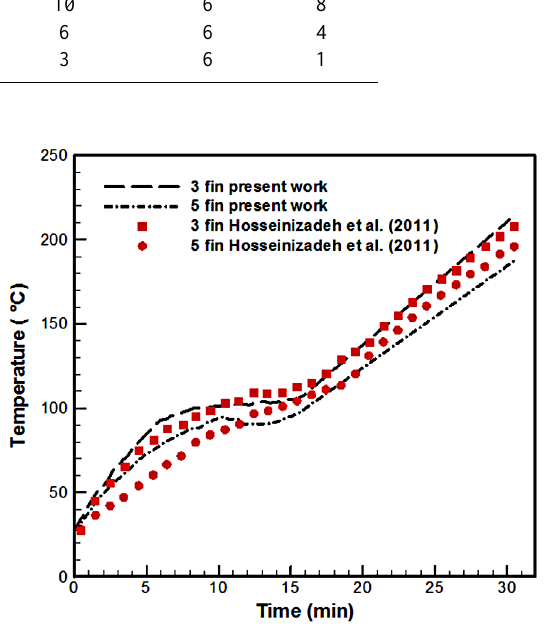
Figure 3. Comparison of base temperature profile between the present work and Hosseinizadeh et al.